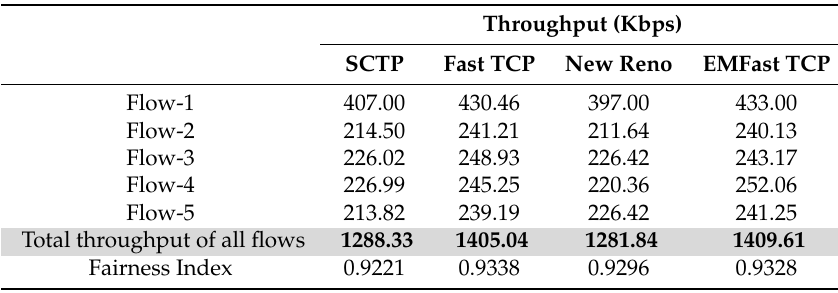
Table 4. End-to-end measured throughput of all the flows.